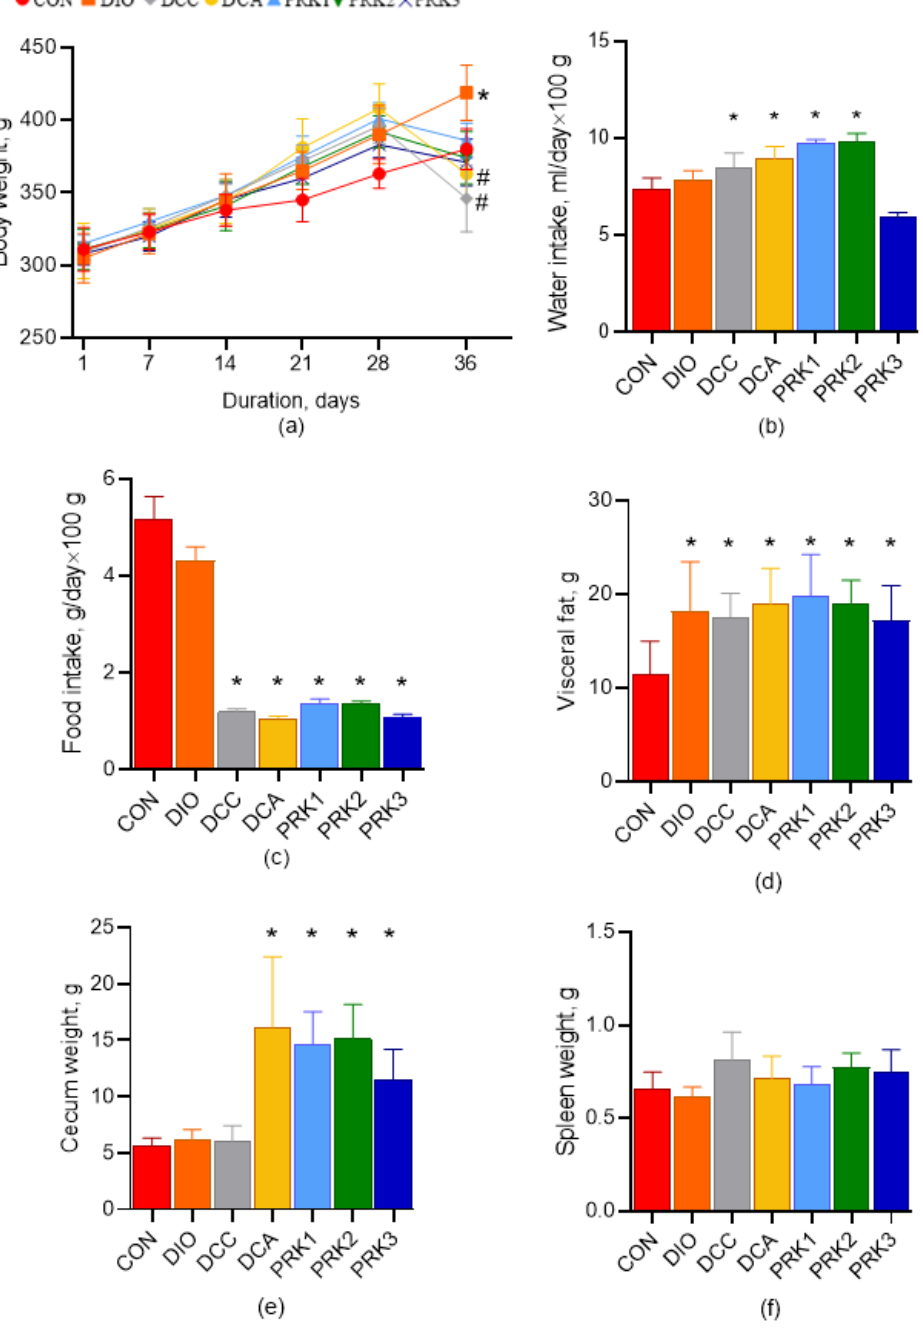
Figure 2. Effects of different treatments on animal body weight, food and water intake, and the weights of visceral fat, cecum and spleen. ( a ) Weekly changes in body weight; ( b ) Average water intake; ( c ) Average food intake; ( d ) Visceral fat weight; ( e ) Cecum weight; ( f ) Spleen weight. Data are expressed as mean ± SD. * indicates p < 0.05 when data is compared to that for the CON group; # indicates p < 0.05 when data is compared to that for the DIO group.